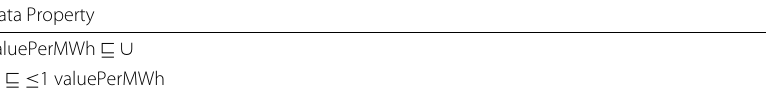
Table 2 MIBEL Ontology data property DL syntax Data Property